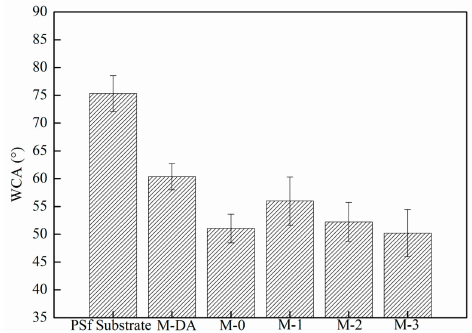
Figure 3. Water contact angles of PSf substrate, M-DA, M-0, M-1, M-2 and